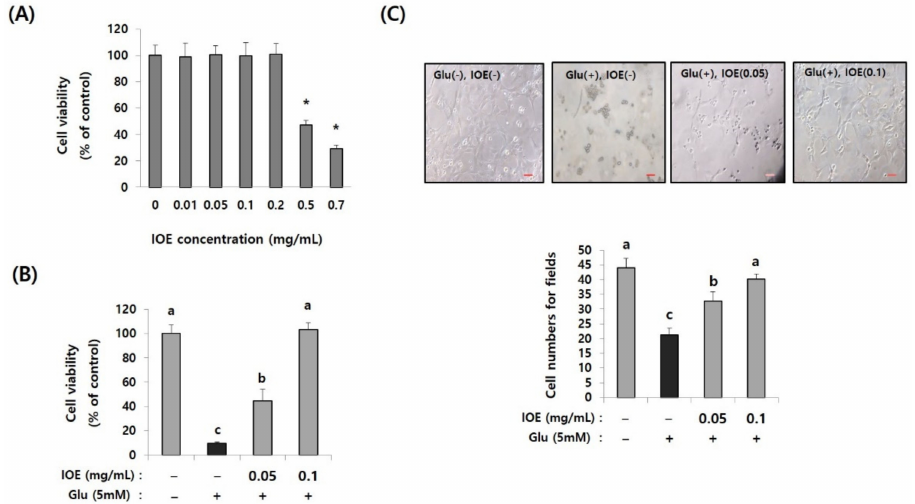
Figure 7. Glutamate-induced cytotoxicity was attenuated by IOE treatment. The cytotoxicity of IOE on HT22 cells was measured by a cell viability assay kit ( A ). The glutamate-mediated cytotoxicity was inhibited by the treatment with non-toxicological levels of IOE. Cell viability was measured by a WST-1 Assay Kit ( B ) and cell counting ( C ). Data value shown are means ± SD. Non-treated cells (IOE- and Glu-) were used for the control. Experiments were repeated three times with similar results. a: significant differences ( p < 0.05) when compared with b or c; b: significant differences ( p < 0.05) when compared with a or c, *: significant difference compared with the control ( p < 0.01). Glu: